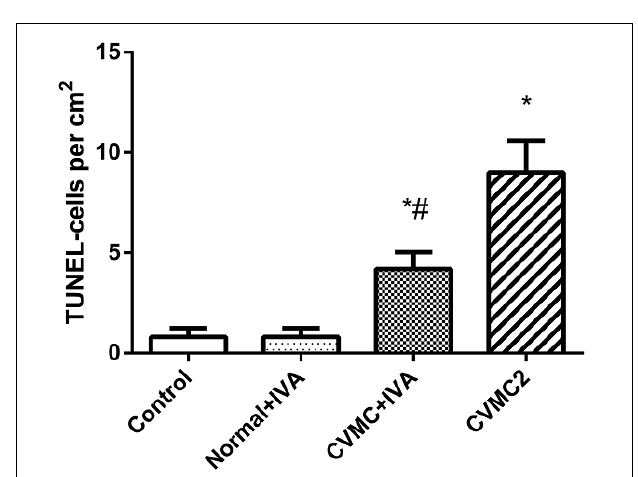
FIGURE 7 | The positive apoptotic cells per cm 2 of TUNEL assay in each groups ( n = 8). The apoptotic percentages in CVMC+IVA group significantly attenuated after treatment with ivabradine (IVA) compared with CVMC2 group. ∗ P < 0.05 vs. Control (Normal control 2 group), # P < 0.05 vs. CVMC2.